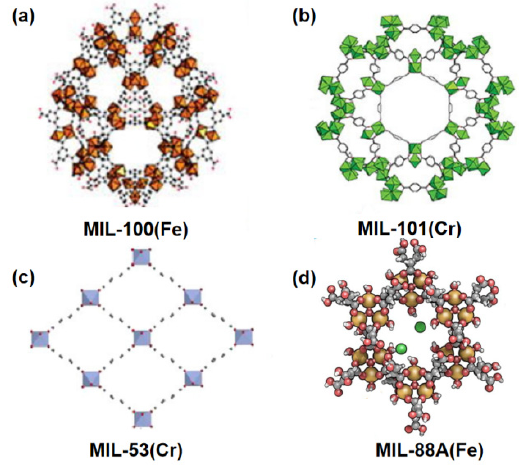
Figure 2. ( a ) The structure of MIL-100(Fe) [20]; ( b ) The structure of MIL-101(Cr) [22]; ( c ) The